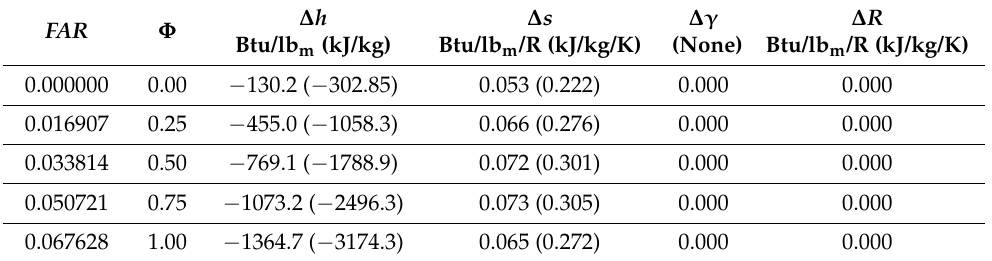
Table 5. Thermodynamic properties corrections.